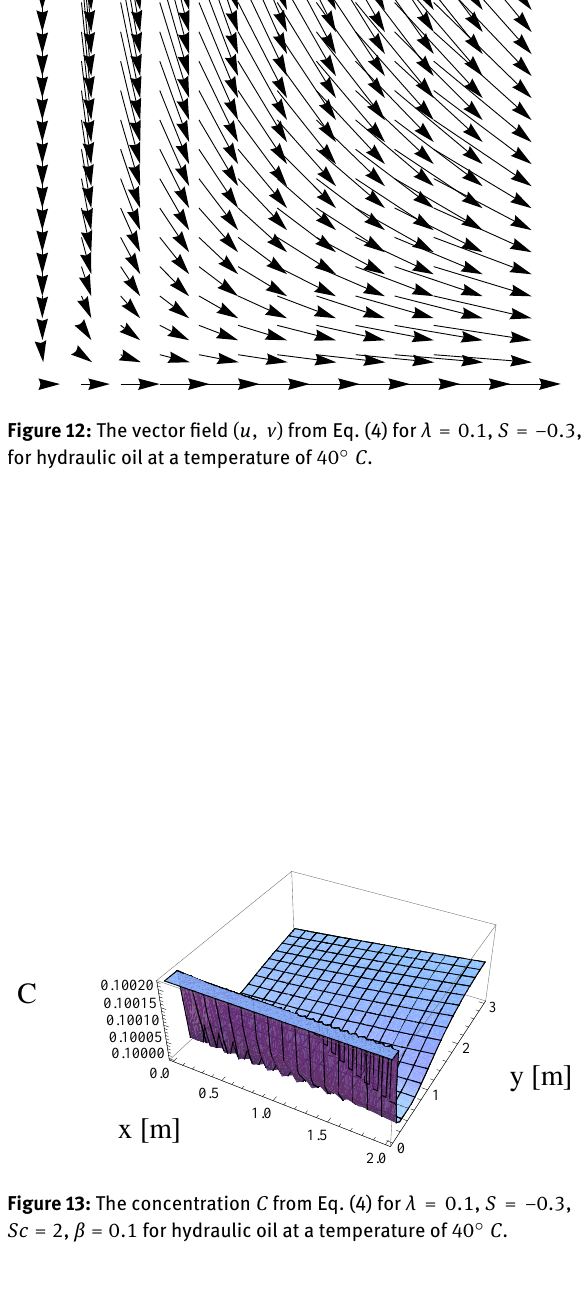
Figure 11: Variation of the velocity component v from Eq. (4) for λ = 0.1 , S = −0.3 , for hydraulic oil at a temperature of 40 ◦ C .